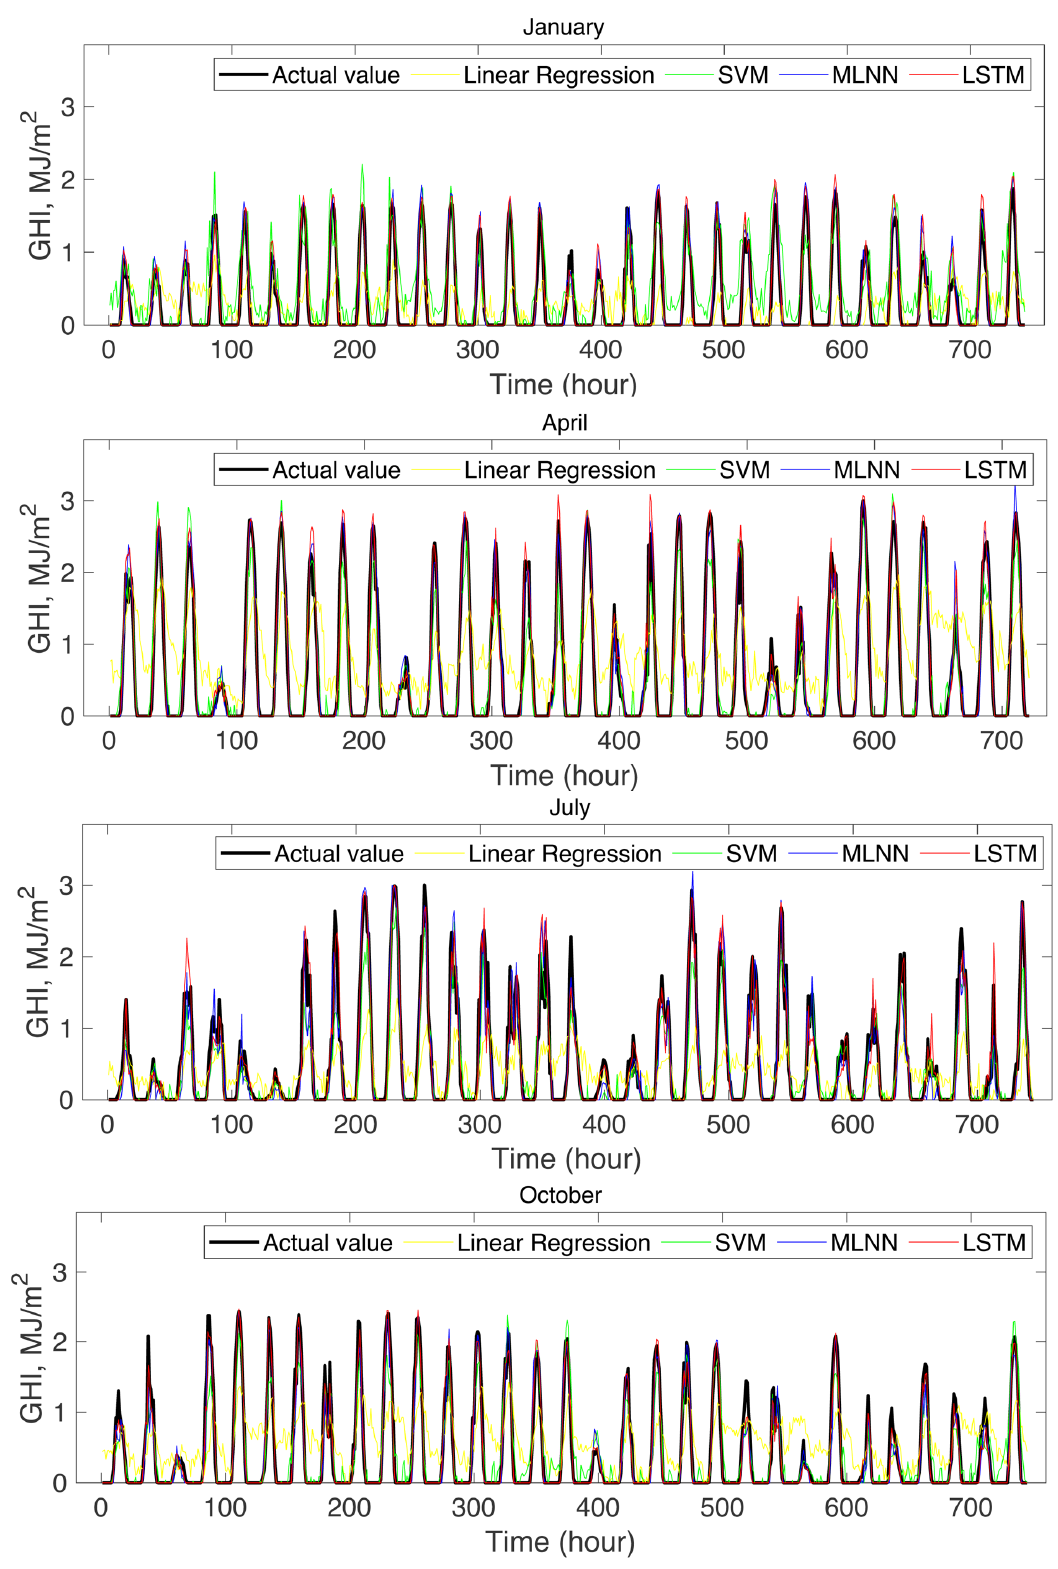
Figure 7. Estimation output of four models compared with real values (January–April–July–October).